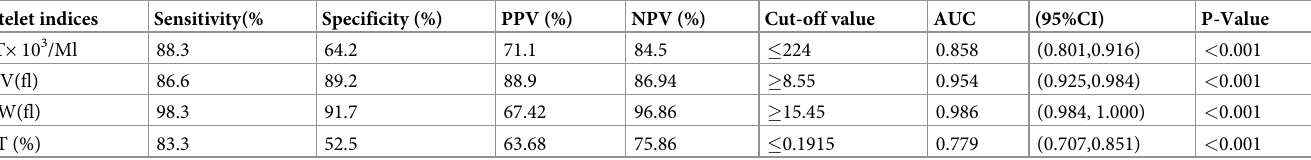
P-value is significant at level < 0.05. Where: PLT × 10 3 / μ l, Platelate in per microliter, MPV Mean Platelet Volume in femtoliter (fl), PDW (fl) Platelet Distribution